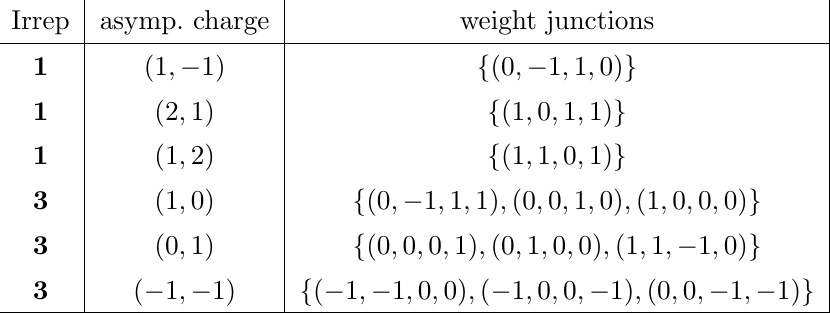
Table 6. Junction vectors with self-intersection 1 in the g -tube for b = 2. We give their irreducible (cid:0) representations under the (cid:13)avor group SU(3), their asymptotic charges, and the corresponding junctions. Again, the negatives of these junctions are in the spectrum as well and correspond to the respective conjugate